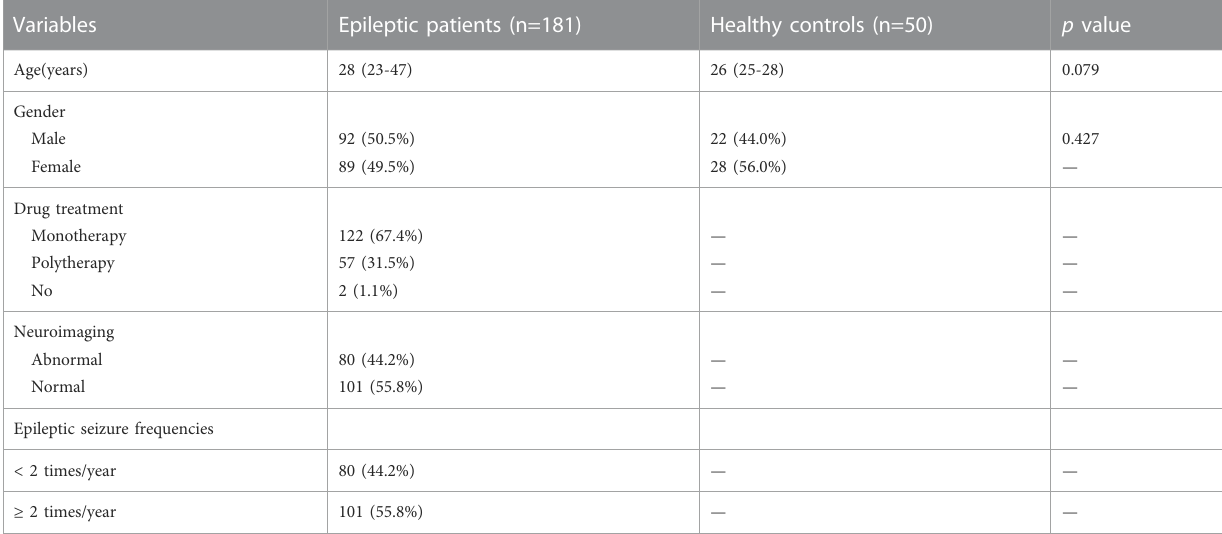
TABLE 1 Demographic and clinical characteristics of the enrolled population.